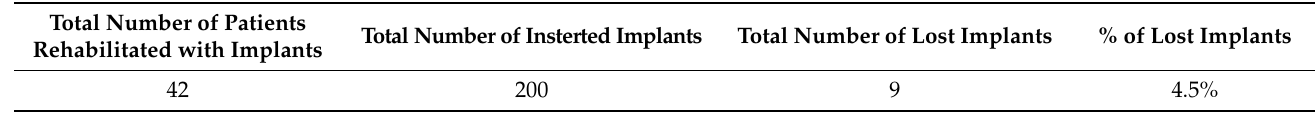
Table 2. Patients rehabilitated with